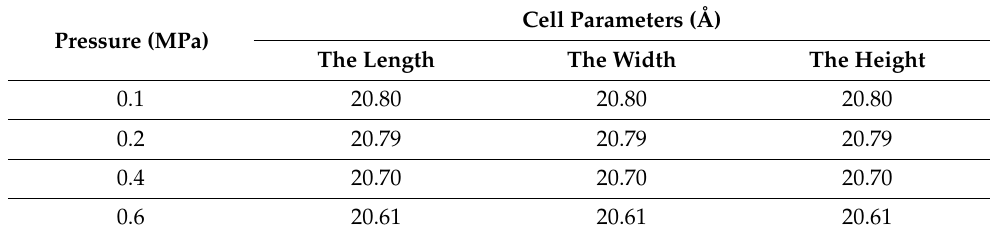
Table 2. The cell parameters of the amorphous cellulose region–water model at different pressures.